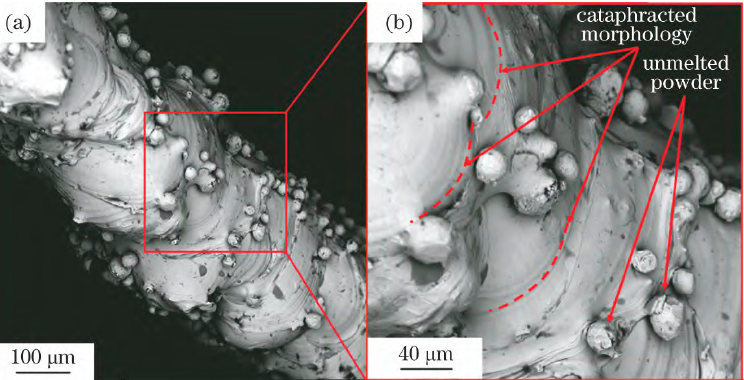
Figure 7. SEM images of microscopic profile . ( a ) Surface topography; ( b ) partially enlarged drawing. Reprinted with permission from Ref. [140]. Copyright2022, copyright Liu Y, Guo J, Shi W.